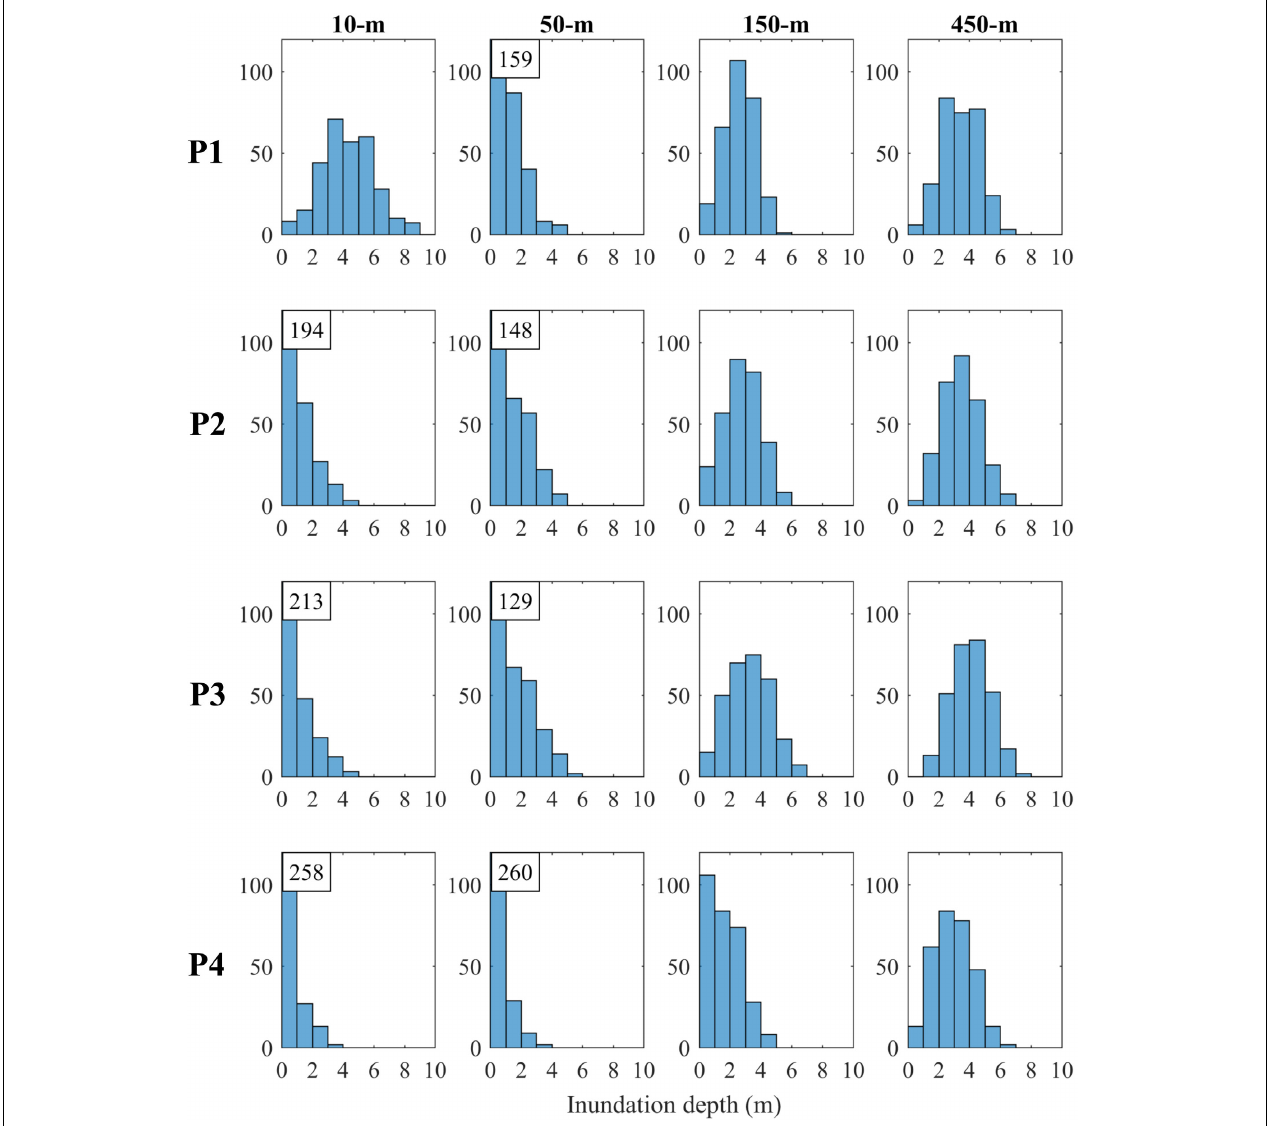
FIGURE 9 | Inundation depth distribution at four locations in Sendai for the M w 9.0 events by considering different DEM resolutions (The counts exceeding the y axis limit are indicated in a box). The histogram in each subfigure panel is based on 300 stochastic slip